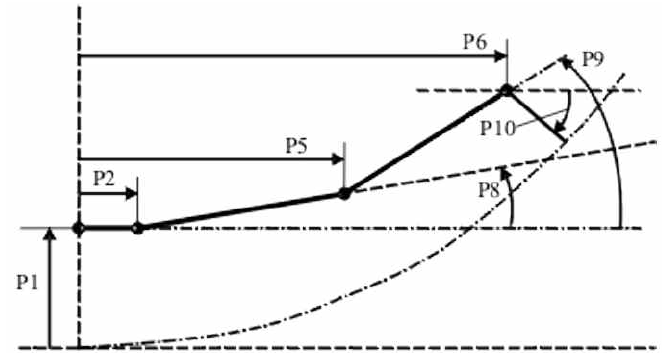
Figure 15. An example of the parameters of the inner bottom control section. Here P1–P6—parameters that determine the shape of the internal structure in the considered section of the vessel along its length (dimensions, angles of